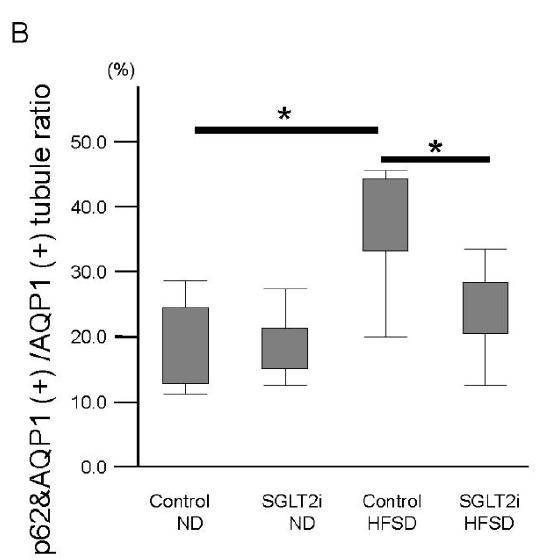
Figure 3. SGLT2 inhibitor (SGLT2i) decreased p62 accumulation on renal proximal tubular cells in obesity mice. ( A ) Immunofluorescence analysis for p62 accumulations; arrow: p62 accumulation. Proximal tubular cells were identified by aquaporin 1 (AQP1) staining. ( B ) Quantitative analysis of p62-positive proximal tubules. Results are presented as the mean ± standard deviation. Differences were evaluated by two-way ANOVA followed by Tukey–Kramer test (* p < 0.05); bars: 10 µm . SGLT2i: empagliflozin.